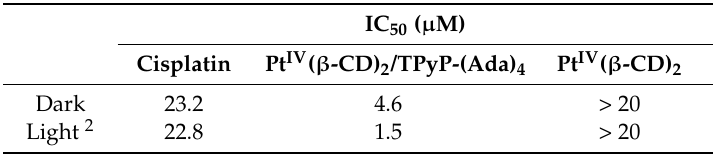
Table 7. Cytotoxicity of the compounds toward A549R cells 1